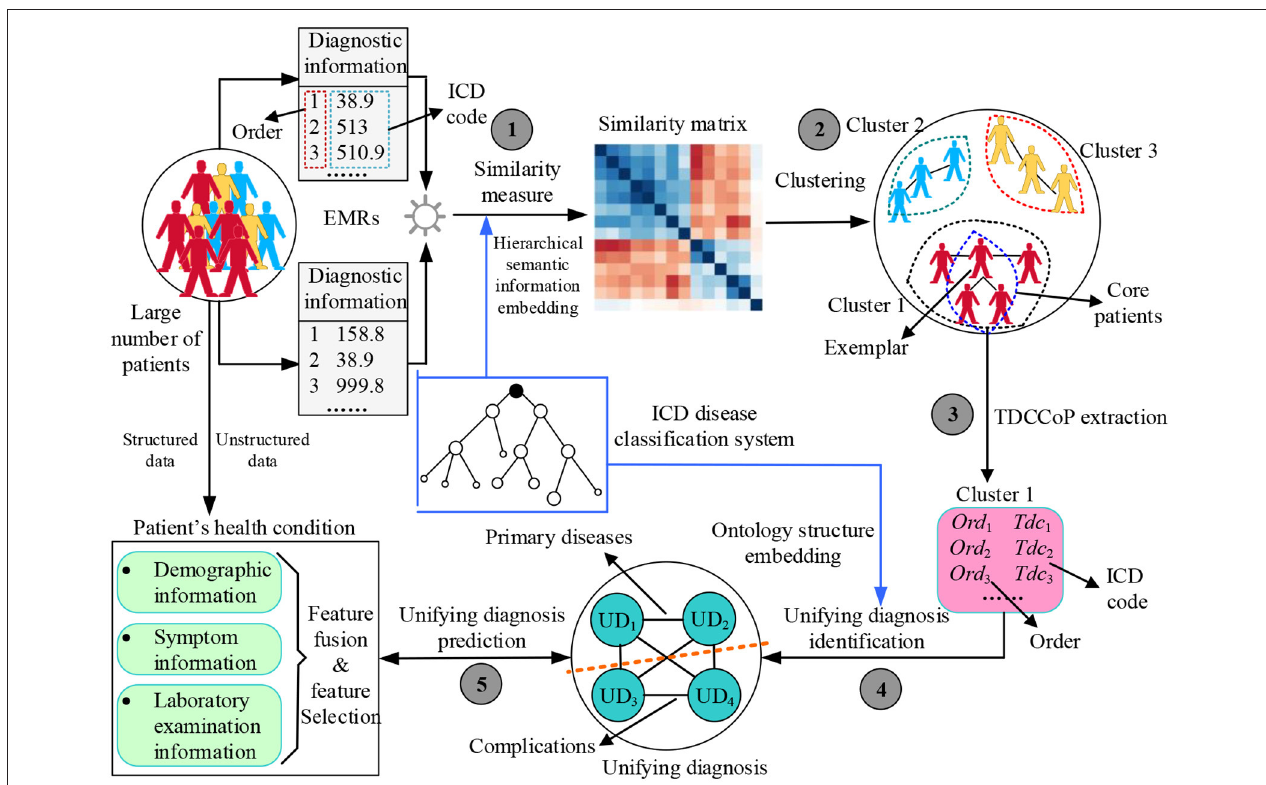
FIGURE 2 | Research framework for applying the proposed UDIPM to